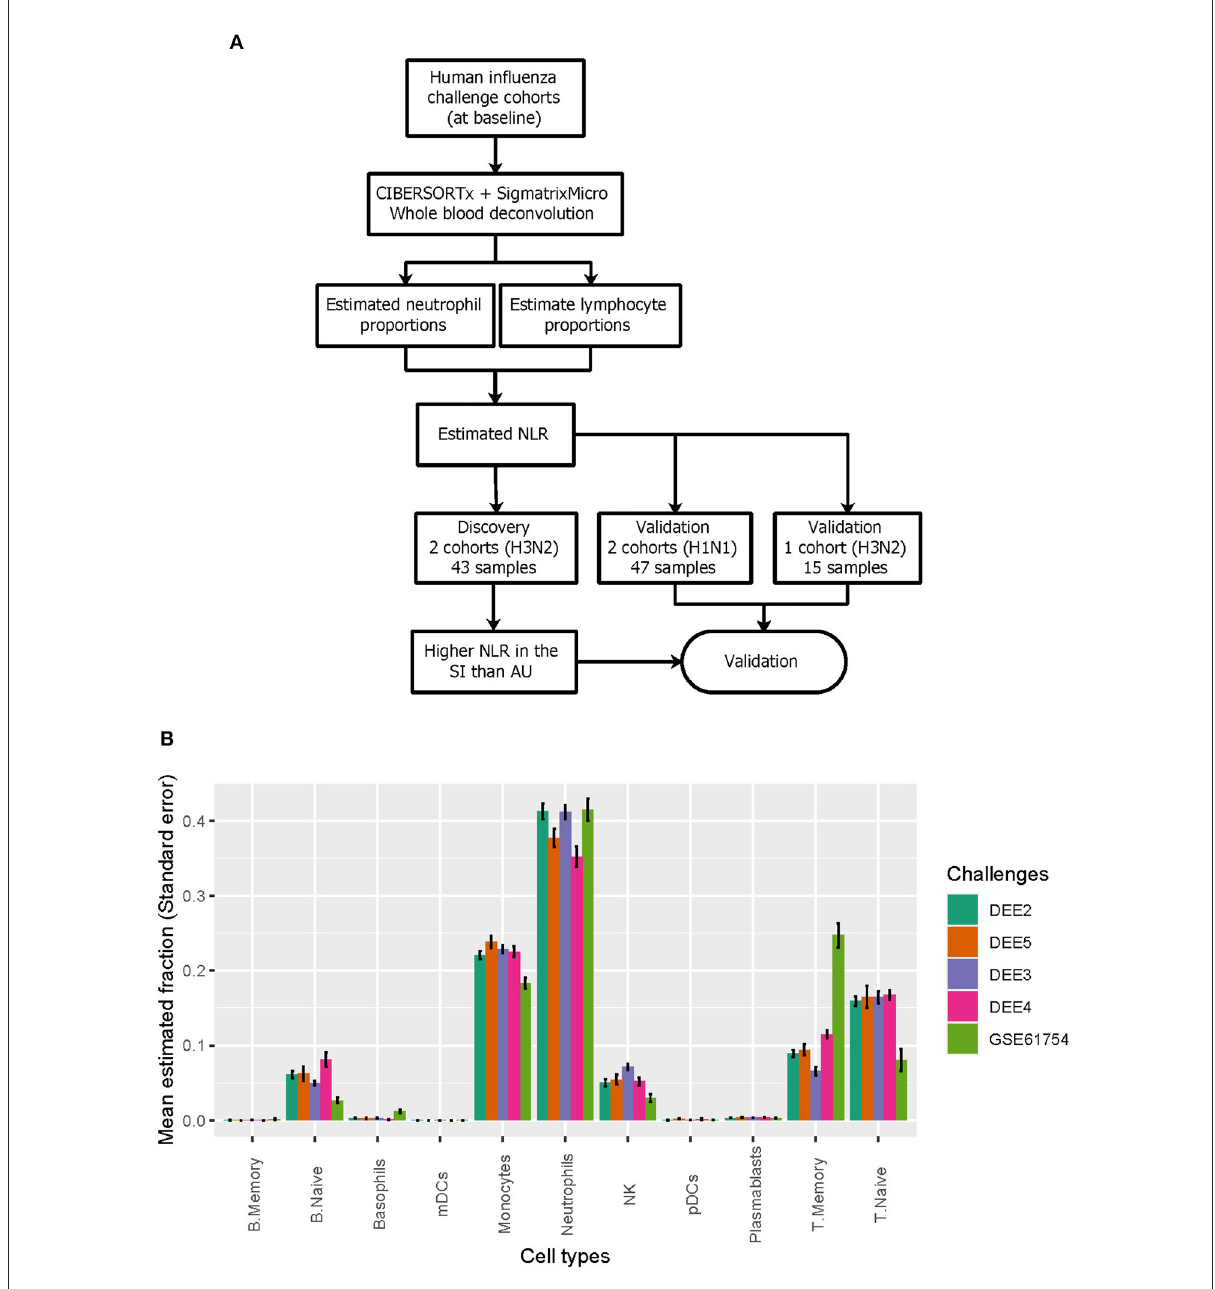
FIGURE2 Deconvolution of immune cell populations from gene expression data. (A) Deconvolution of immune cell populations reveals difference in NLR between SI and AU groups. (B) The relative abundance of 11 immune cell populations.